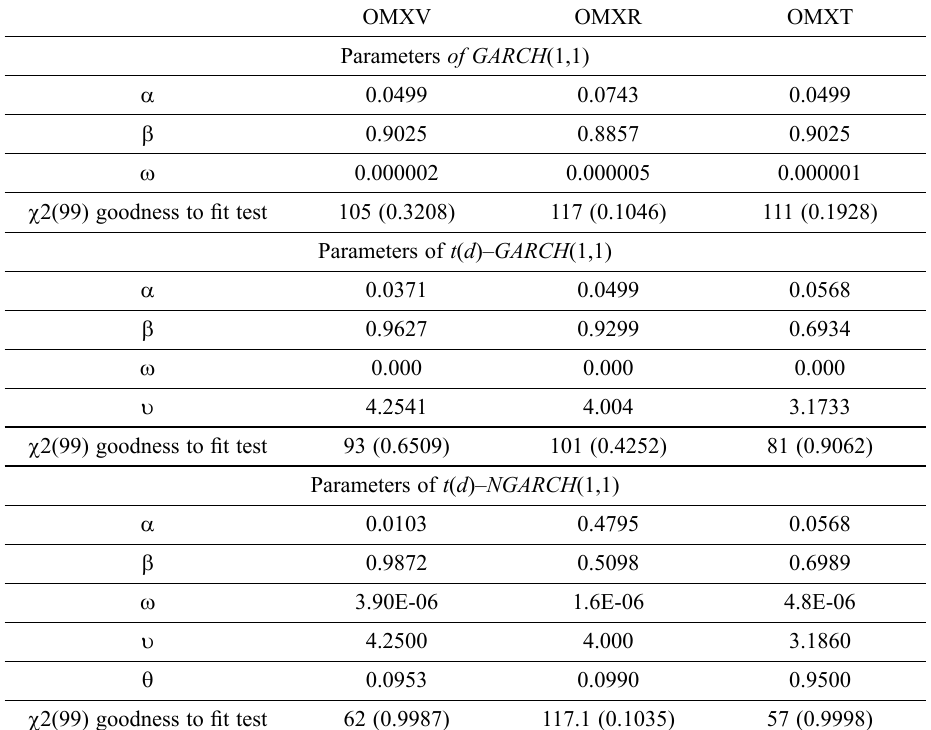
Table 2. Estimates of the parameters of GARCH (1,1)